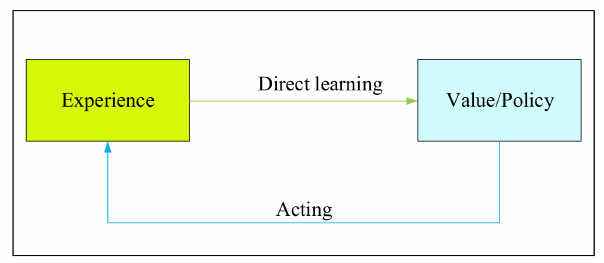
Figure 11. Free-model learning